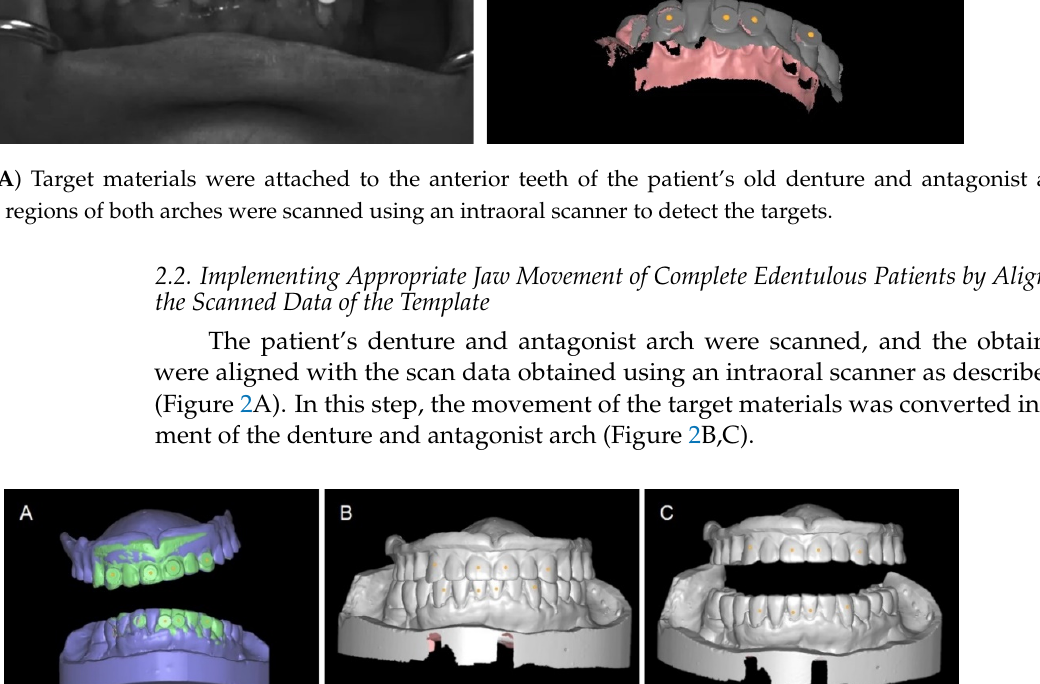
Figure 4. The jaw motion data of the old denture state implemented in Figure 2 converted into motion data in the complete edentulous arch. ( A ) Closed mouth. ( B ) Tracking movement while opening the mouth. ( C ) Extracting the maxillary and mandibular meshes of the desired height in the tracking trajectory. Figure 5. ( A ) By measuring the distance between the mandibular anterior teeth and the maxillary anterior edentulous ridge, one is able to ascertain the appropriate vertical dimension. ( B ) A bar attachment can be placed in the restorative space to evaluate whether it is adequate. The maxillary and mandibular stereolithography files with the desired vertical di- mension can be exported and then used to design trial dentures with the aid of the denture design module of the 3D CAD software (3Shape Dental System, 3Shape, Copenhagen, Denmark). When designing a trial denture, the clinician can adjust the anterior tooth ar- rangement by referring to or supplementing the lip support and aesthetics of the anterior tooth from the previous denture (Figure 6). The clinician can make trial dentures that have various designs and vertical heights. The designed trial dentures were printed using a 3D printer (Form3, Formlabs, Som- erville, MA, USA) and 3D printing resin (NextDent C&B, 3D Systems, Soesterberg, the Netherlands) (Figure 7A). The clinician can place each trial denture in the patient’s mouth and then select the most appropriate denture for further treatment (Figure 7B). The clini- cian can use the trial denture to select an appropriate vertical height and restorative space, and then complete the temporary denture and provide it to the patient. For the deter- mined vertical dimension and restorative space, the clinician can select the final prosthesis